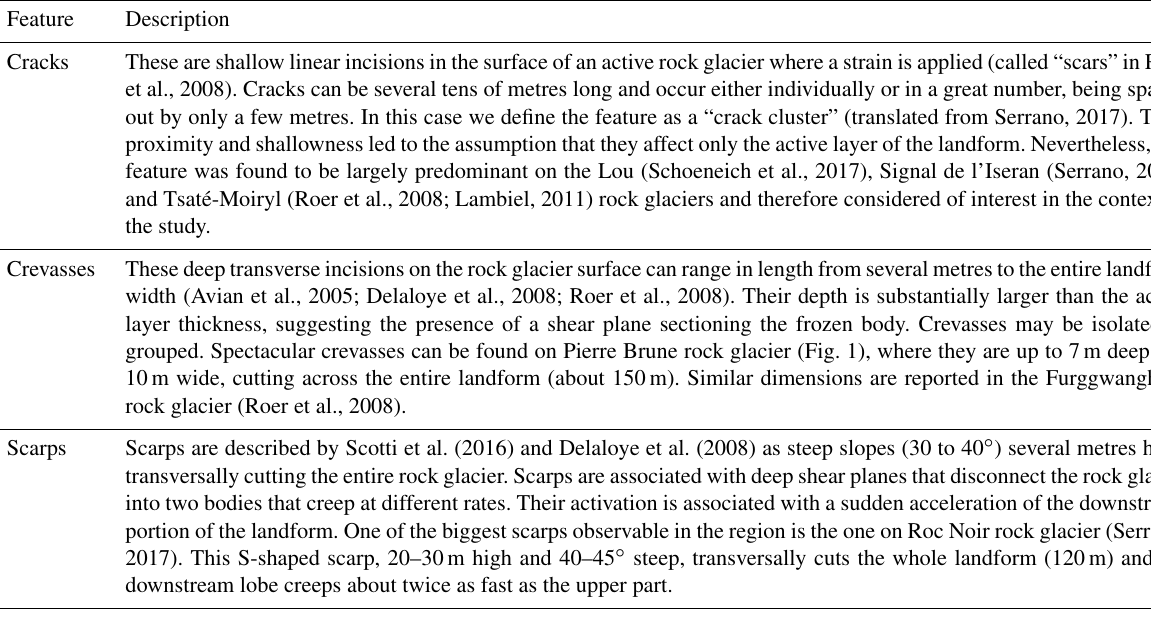
Table 1. Description of surface disturbance features that could be observed in the field or from orthoimagery to identify signs of rock glacier